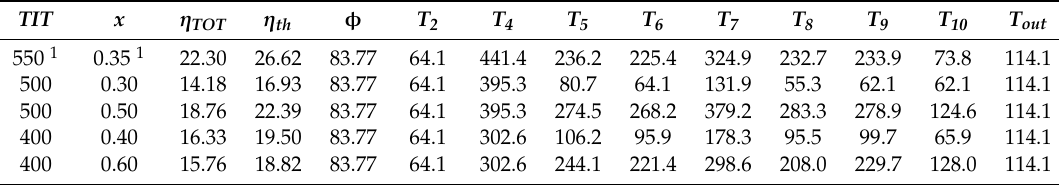
Table 2. Performance metrics and cycle parameters at the optimum and four sub-optimum points for the single flow split with a dual expansion cycle. All temperatures are in ◦ C.